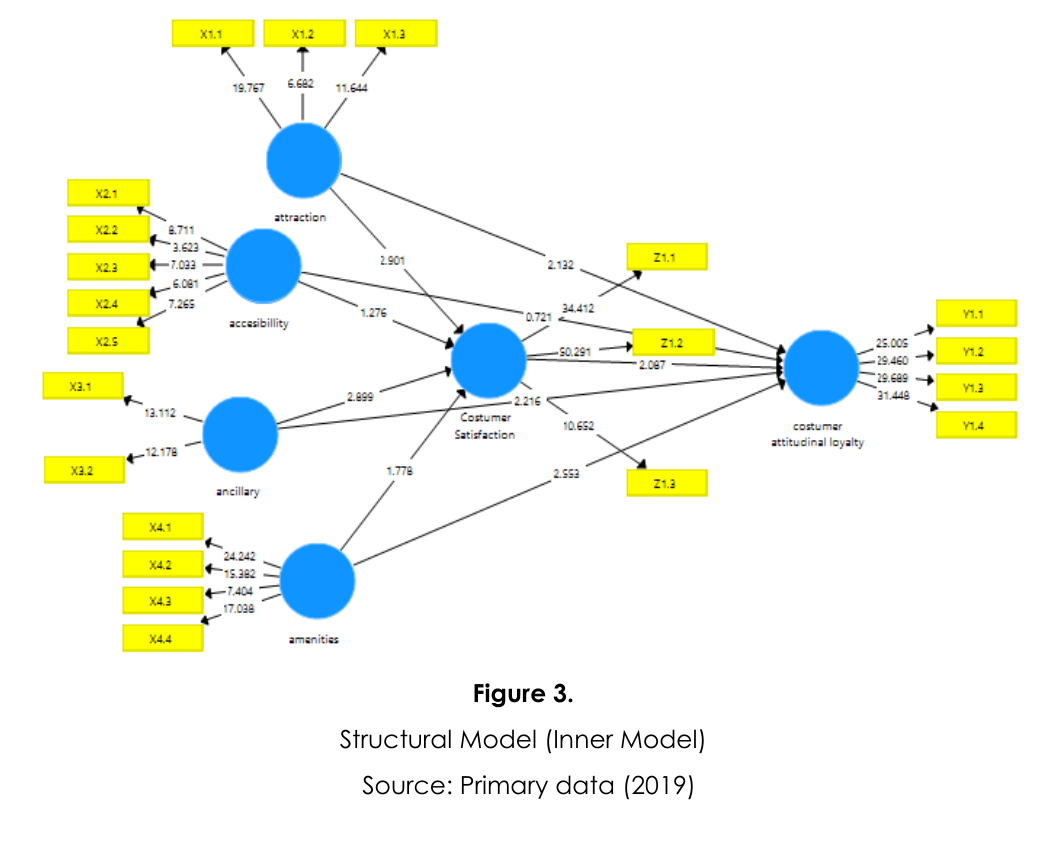
Structural Model (Inner